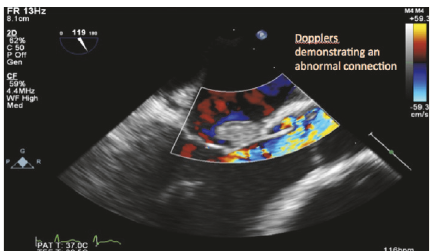
Figure 1: Valvular vegetation with possible abscess.